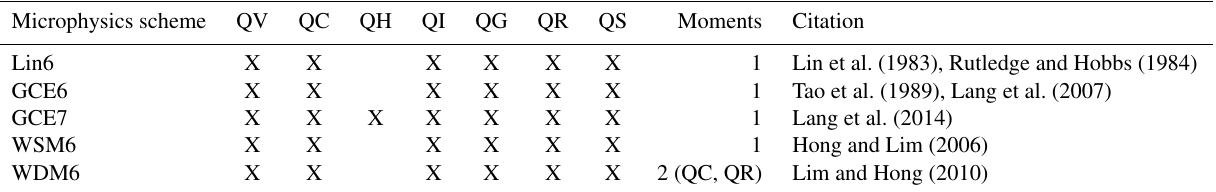
Table 2. Applied bulk microphysics schemes and their characteristics. The below table indicates simulated mixing ratio species and number of moments. Mixing ratio species include: QV is water vapor, QC is cloud water, QH is hail, QI is cloud ice, QG is graupel, QR is rain, QS is snow. Microphysics